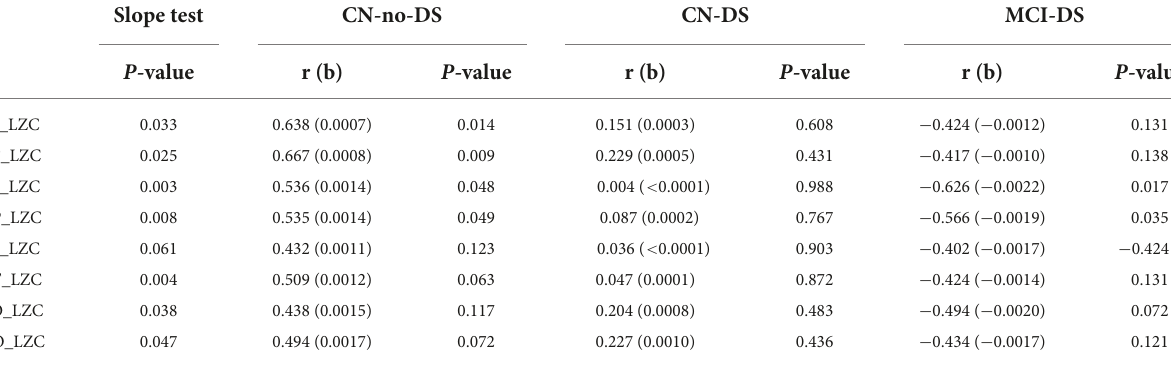
TABLE 3 F -test for differences among regression slopes ( p -value), Correlation coefficients (r), slopes (b), and p -values between Age and LZC variables by groups. Slope